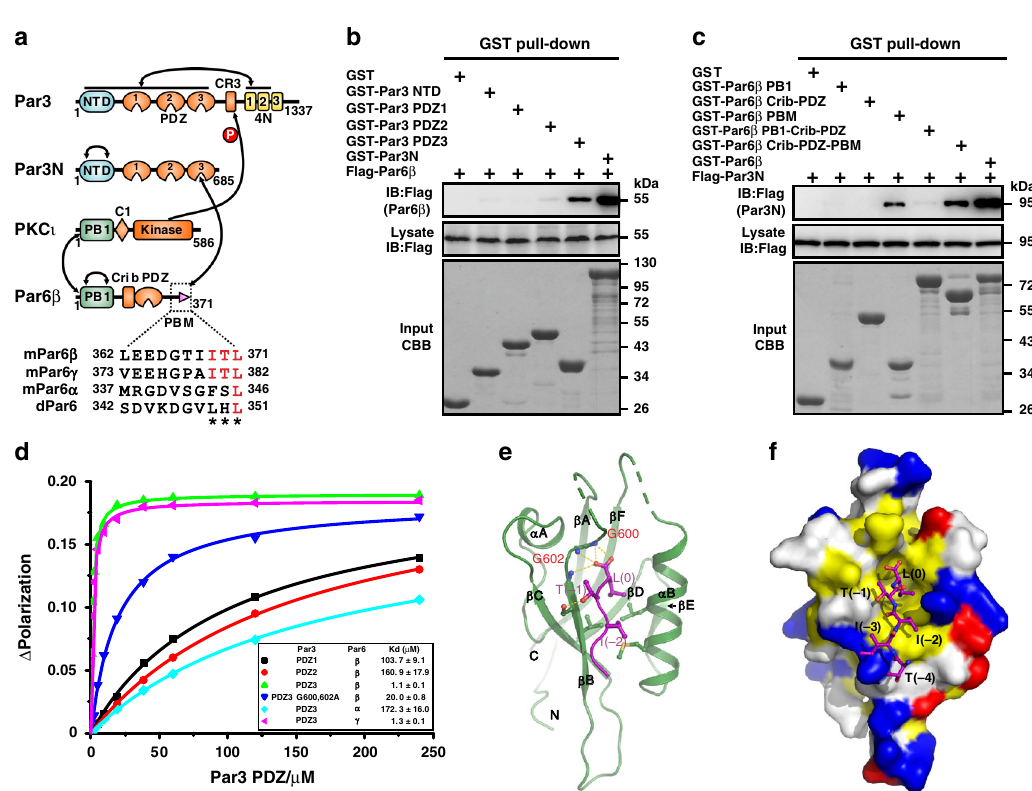
Fig. 4 Par3 recognizes Par6 via the interaction between Par3 PDZ3 and Par6 PBM. a Schematic diagrams showing the domain organizations of Par3, Par6 β , and PKC ι . Amino acid sequences of the PBM from mouse Par6 α , Par6 β , Par6 γ , and Drosophila Par6 are present bellow, with the completely conserved residues colored in red. b Cell lysate GST pull-down assay of various GST-tagged rat Par3 fragments (NTD, PDZ1, PDZ2, PDZ3, or Par3N) with Flag-Par6 β . Par3 PDZ3 speci fi cally bound to Par6 β , and the interaction was strongly enhanced by Par3 NTD. c Cell lysate GST pull-down assay of various GST-tagged mouse Par6 β fragments (PB1, Crib-PDZ, PBM, PB1-Crib-PDZ, Crib-PDZ-PBM, or full-length Par6 β ) with Flag-Par3N. Par6 β PBM speci fi cally bound to Par3, which was sharply enhanced by Par6 β PB1. d Fluorescence polarization-based measurements of the binding af fi nities between Par3 PDZs (PDZ1, PDZ2, PDZ3, or PDZ3 G600, 602 A) and various Par6 (Par6 α , Par6 β , or Par6 γ ) PBM peptide. e Ribbon representation of the Par3 PDZ3 (green)/ Par6 β PBM (purple) complex. Key residues involved in Par3/Par6 binding are shown as a ball-and-stick model. f Combined surface (Par3 PDZ3) and stick (Par6 β PBM) diagram of the complex. In the surface map, hydrophobic residues are colored in yellow, positively charged residues in blue, negatively charged residues in red, and other residues in white. Experiments were performed three times independently with similar results. All the constructs are listed in Supplementary Table 1. Source data are provided as a Source data fi